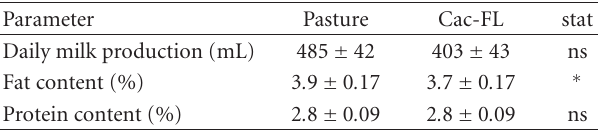
Table 1: Milk production and